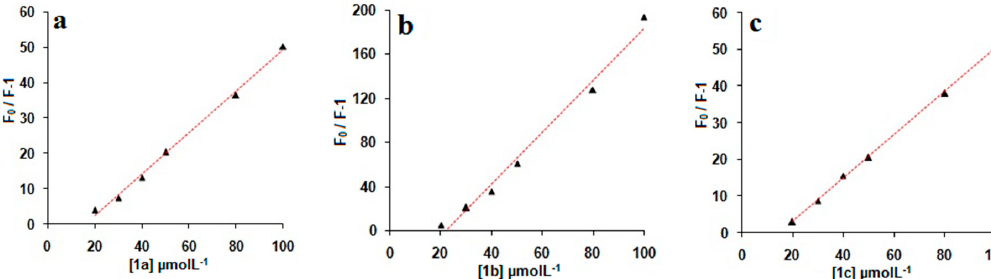
Figure 4. F 0 /F-1 value changes with the concentration of added ( a ) 1a, ( b ) 1b, ( c ) 1c . The red straight lines are the fitting results from using the Stern–Volmer equation.